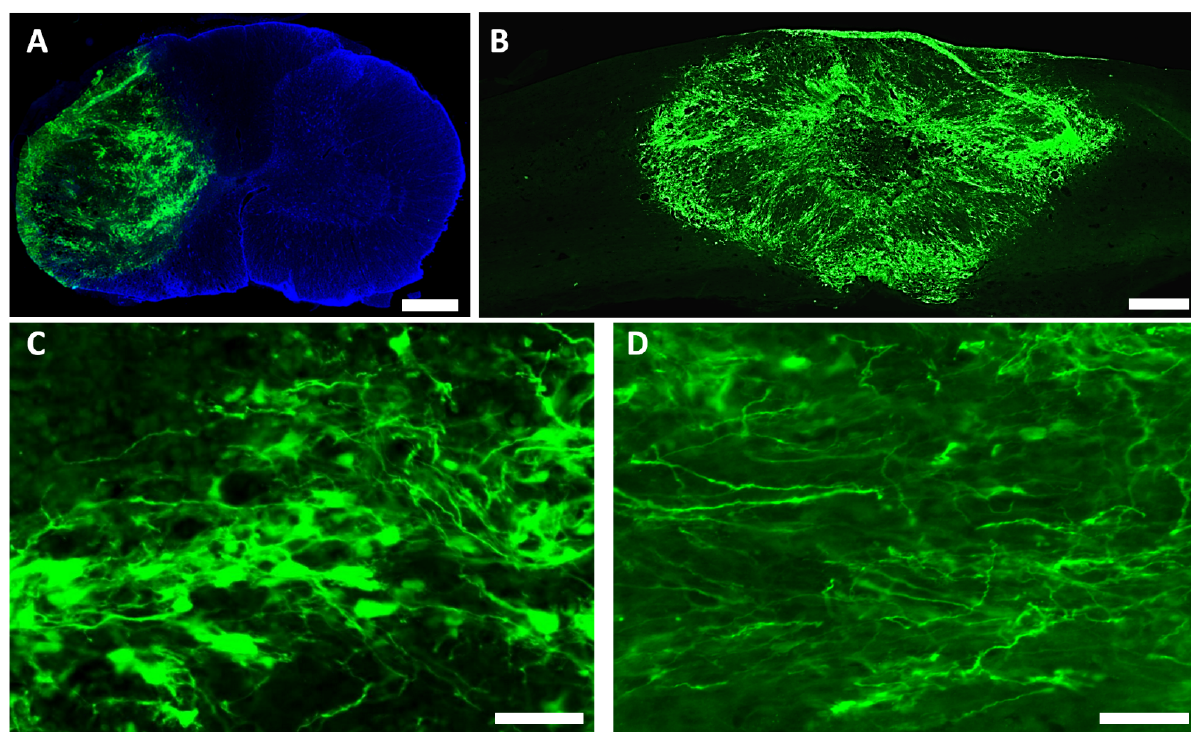
Figure 3. Survival of grafted hiPSC-derived neural progenitor cells. Human iPSC-derived NPCs were transplanted at 2 weeks after moderate C5 unilateral contusion SCI (IH 150 kdyne) in nude rats. Robust survival of grafted NPCs was observed in all animals that received hiPSC-NPC grafts at 2 months after transplantation ( A , B ). The grafted NPCs filled the lesion cavity and primarily remained in areas around the injury epicenter at the injury side ( A , B ). Grafted hiPSC-NPCs differentiated into cells with the morphology of neurons ( C ), with long processes extending to the spared host spinal cord ( D ). Scale bars: ( A , B ), 500 μ m; ( C , D ), 50 μ m.